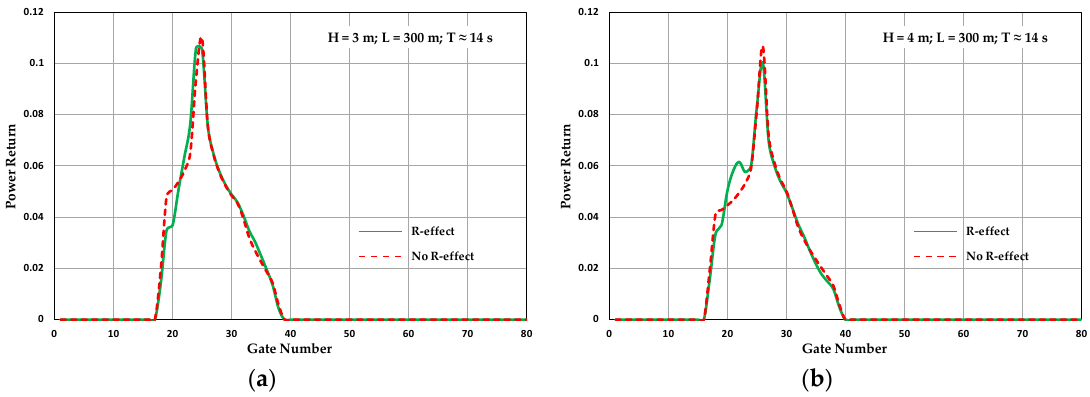
Figure 6. Simulated waveform with (solid green line), and without (dashed red line), R-effect for two different single sine wave trains: ( a ) wave height H = 3 m, wavelength L = 300 m, wave period T ≈ 14 s; ( b ) H = 4 m, L = 300 m, T ≈ 14 s.